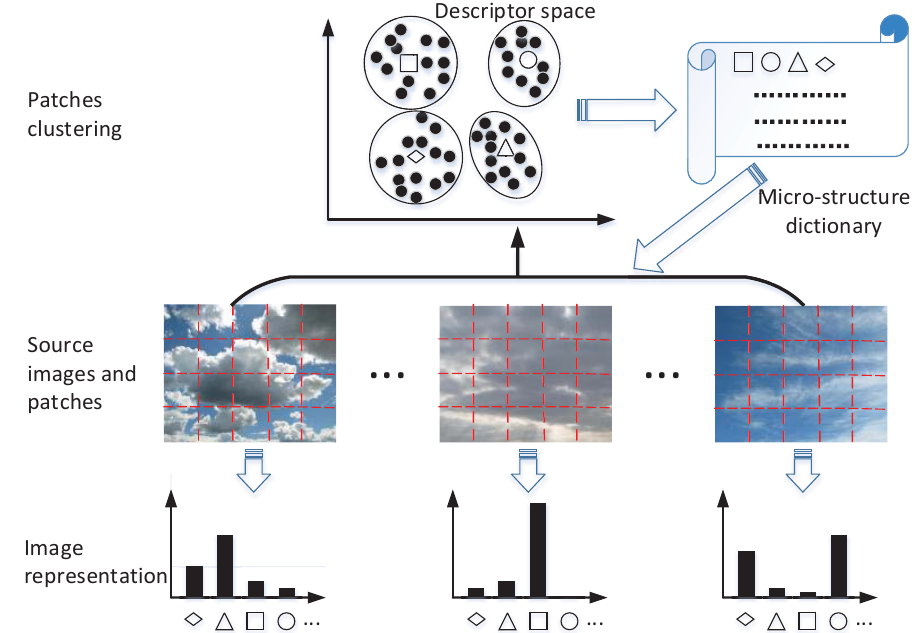
Figure 6. Image representation based on micro-structures, in which patch descriptors are grouped to construct micro-structure dictionary, and histogram of such micro-structures in an image is used as its